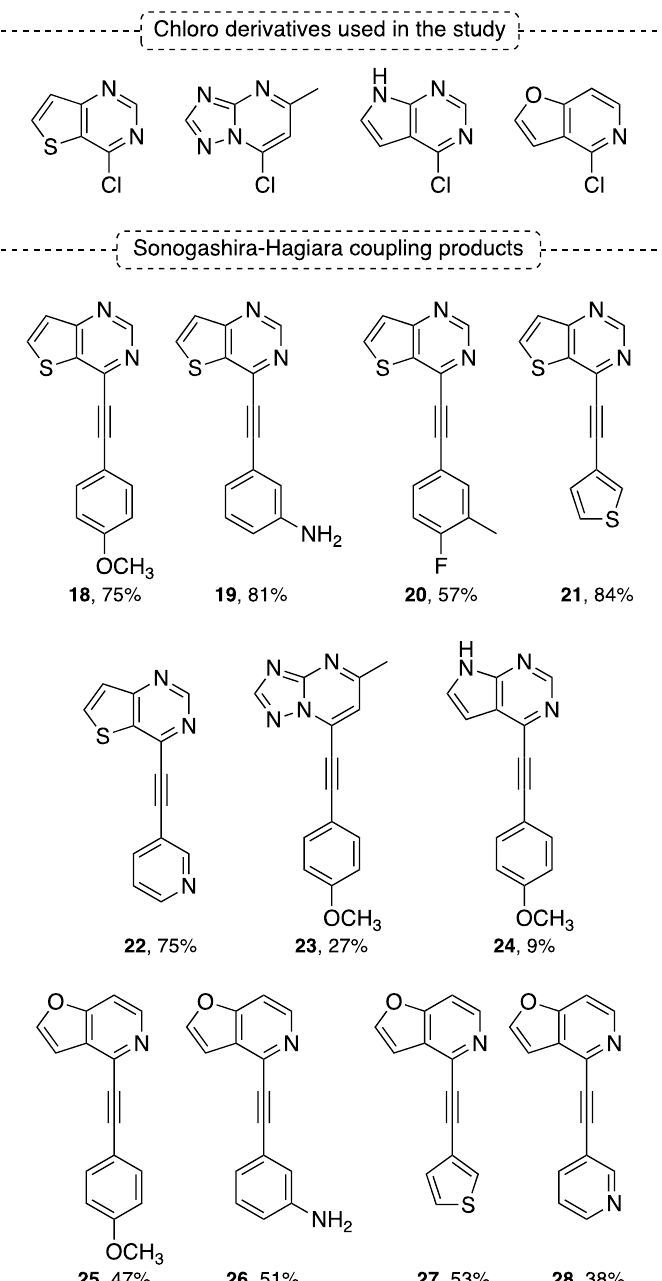
Figure 5. Sonogashira – Hagihara coupling products in eucalyptol [120].